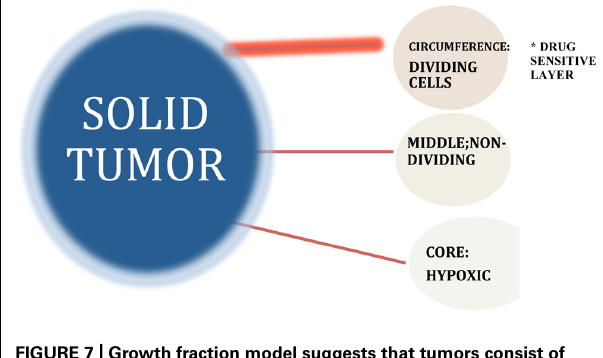
FIGURE 7 | Growth fraction model suggests that tumors consist of pools of both proliferating and non-proliferating cells, with only the former category possessing the intrinsic biological capacity to respond to drugs that specifically target dividing cells. Differential localization of cells within a solid tumor give rise to marked gradients in the rate of cell proliferation as a result of decreasing diffusion rates for oxygen, nutrients, and growth factors-associated abnormal vascularization of the solid tumor interior. Intrinsic chemotherapy resistance results when non-dividing cancer cells do not respond to S- and M-phase chemotherapy drugs that block cell proliferation by virtue of the fact that they are not in either the S- or M-phase of the cell cycle at the time of treatment (Komarova andWodarz,